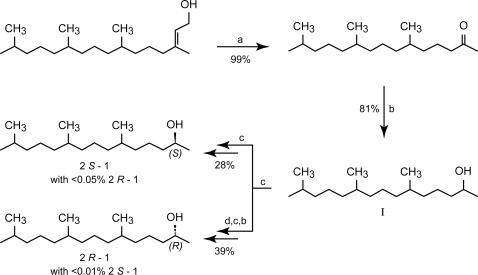
Synthesis of a mixture of all eight stereoisomers of 6,10,14-trime-15-2-ol (1), of (2R,6R/S,10R/S)-6,10,14-trime-15-2-ol (2R-1) and of (2S,6R/S,10R/S)-6,10,14-trime-15-2-ol (2S-1).(a) NaIO4, RuCl3, CH3CN, H2O. (b) (i) LiAlH4/Et2O. (ii) H2O/H3O+. (c) (i) CALB, vinyl acetate, heptane, 4Å molecular sieves. (ii) LC-separation of the produced 2R-acetate and the remaining 2S-alcohol. (d) Hydrolysis of the 2R-acetate using KOH/MeOH (2,4M).